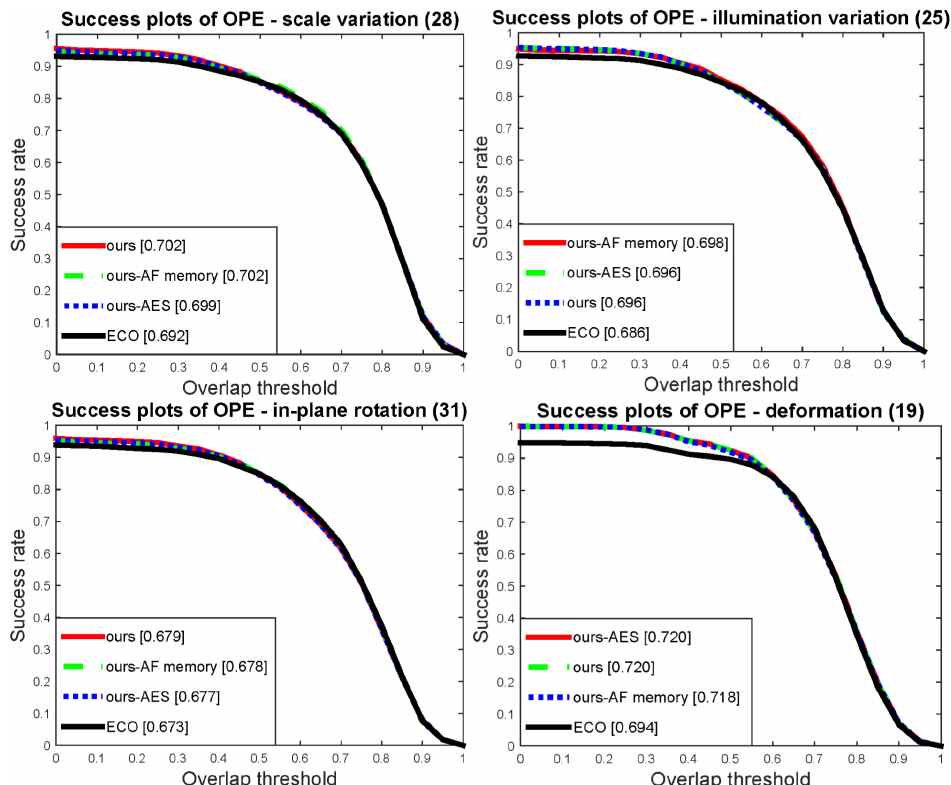
Figure 7. Success plot on scale variation, illumination variation, in-plane rotation, and deformation. The AUC score of each challenge factor is shown in the